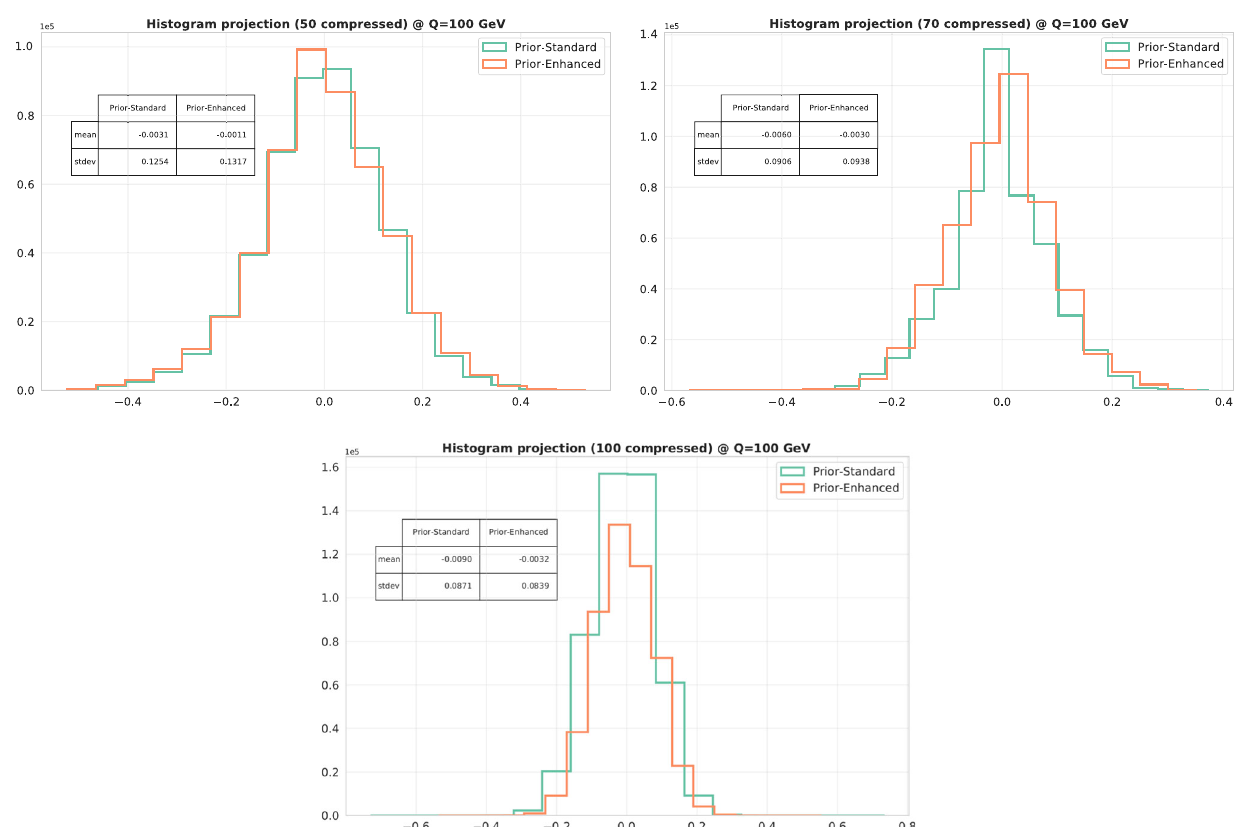
Fig. 14 Histogram projection of the difference in correlation matrices given in Fig. 13. The green and orange lines represent the resulting differences for the standard and enhanced compression respectively, i.e